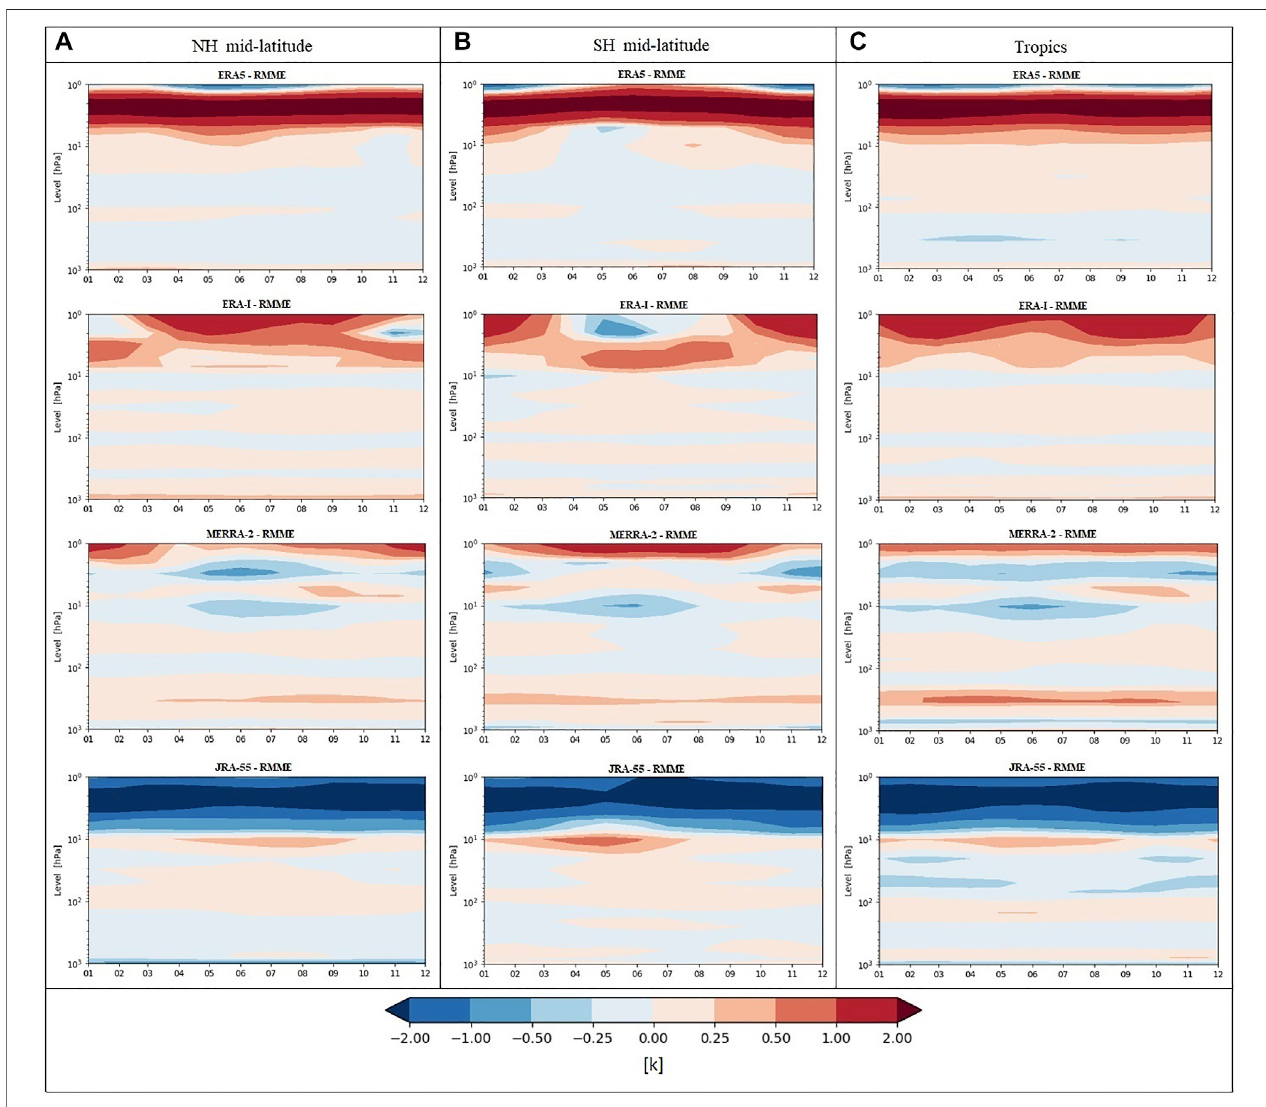
FIGURE 4 | Same as Figure 3 but for the period